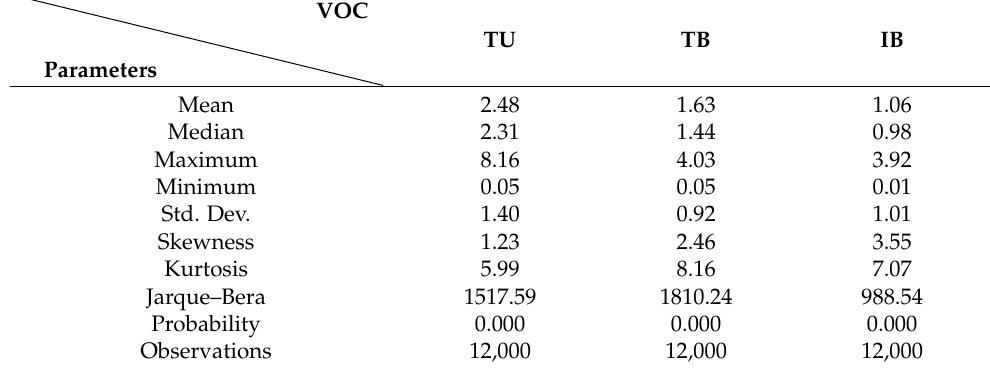
Table 1. Fundamental properties of the 3 VOCs in mobile pollution factor. VOC TU Parameters